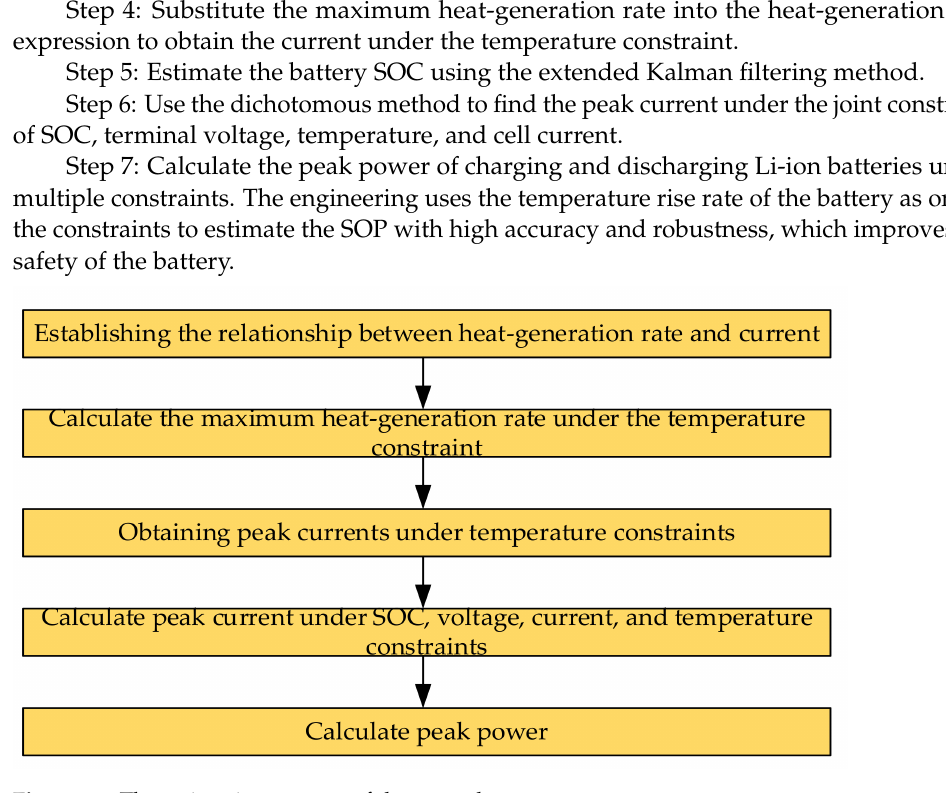
Figure 19. The estimation process of the second type.